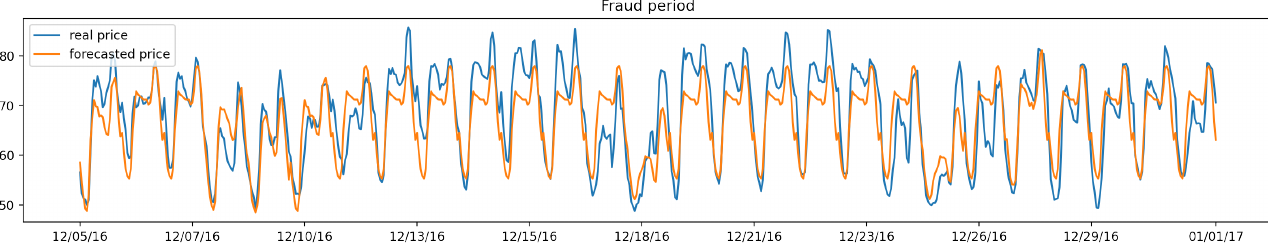
Figure 8. Comparison between actual and predicted price by model Tree using validation data for the fraud data